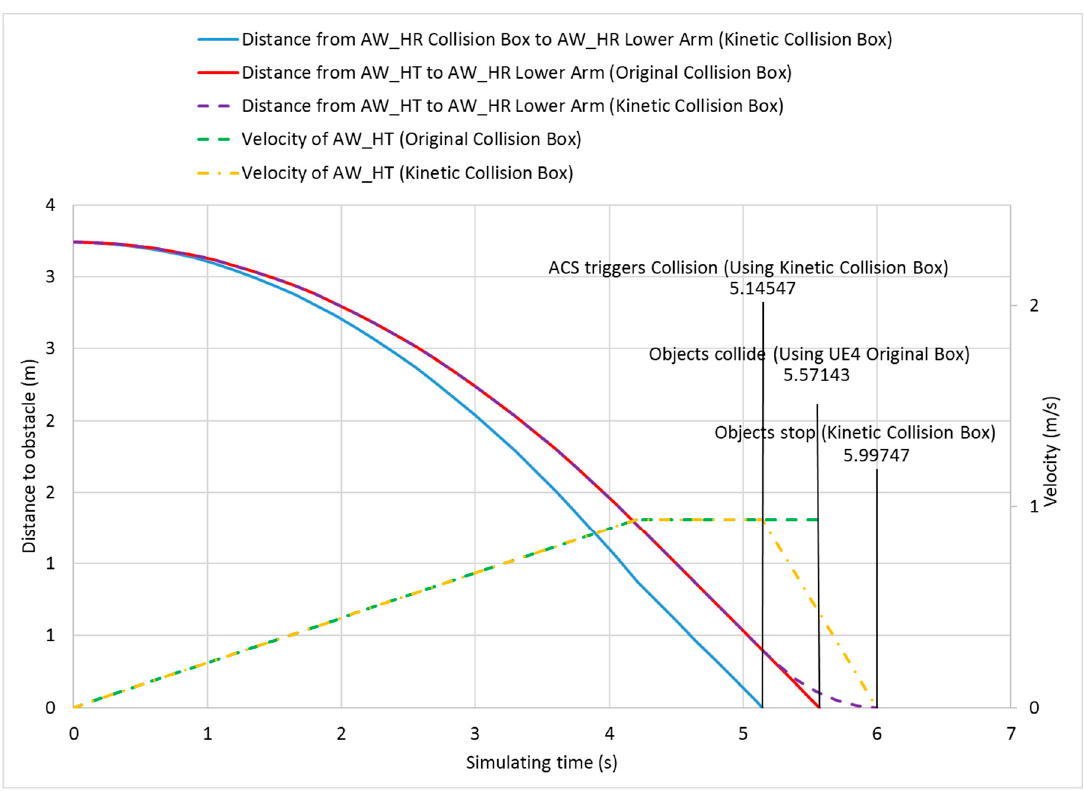
Figure 15. Functionality of kinematic collision box algorithm in Scenario 3.